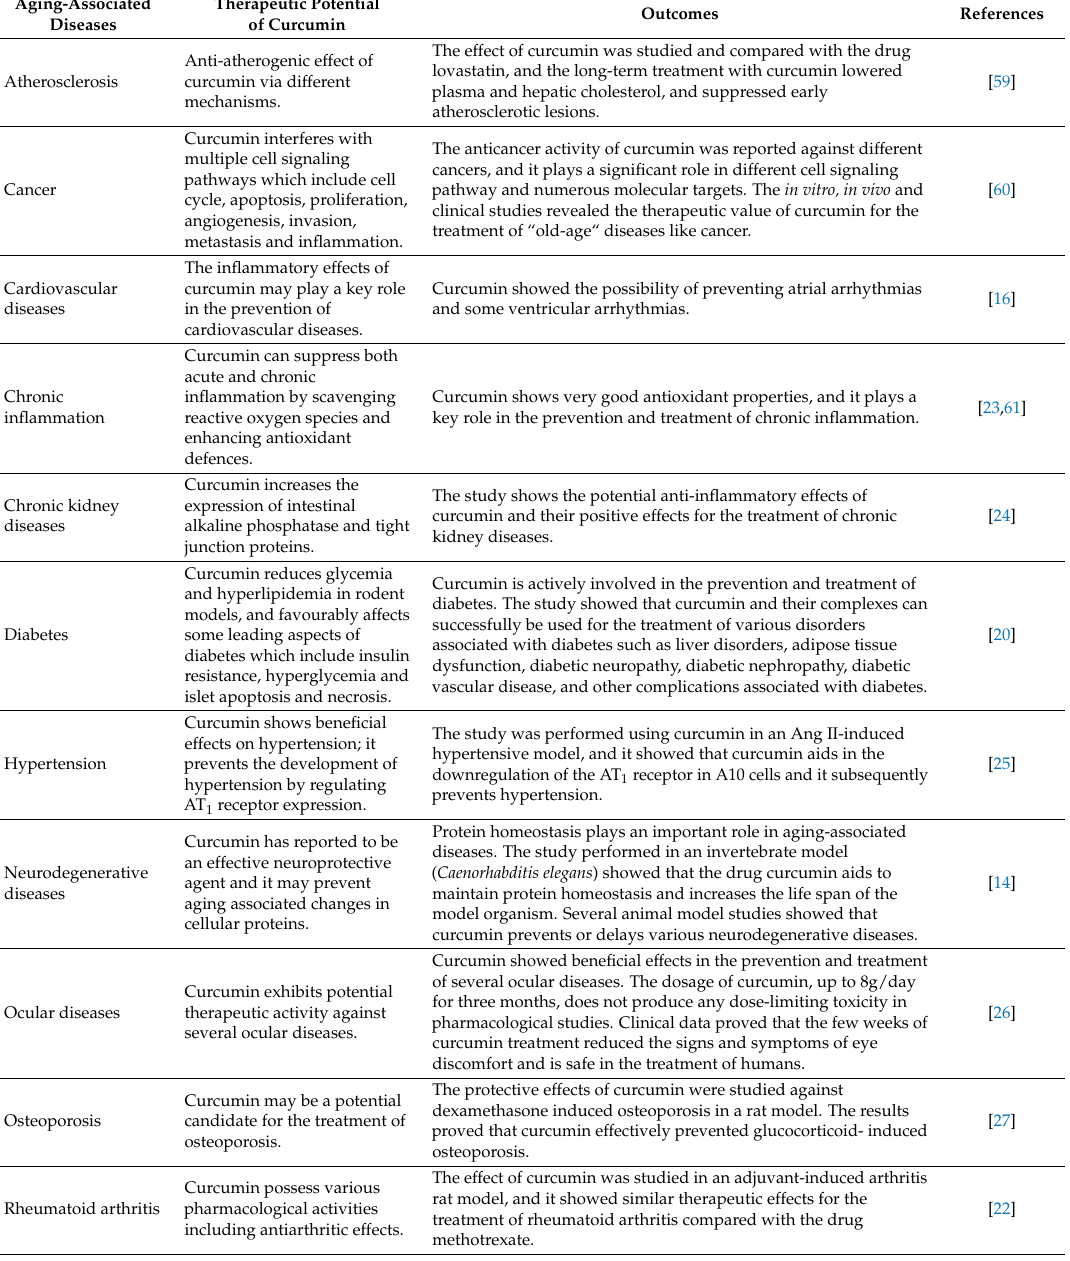
Table 2. Therapeutic potential of curcumin used in the treatment of aging-associated